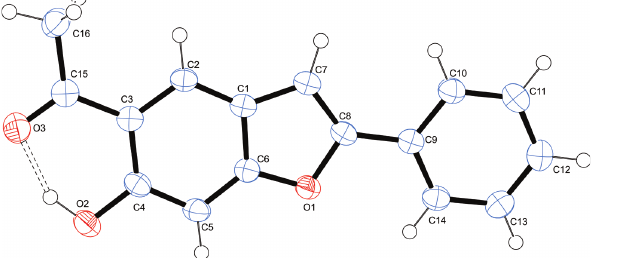
Table 1: Data collection and handling.